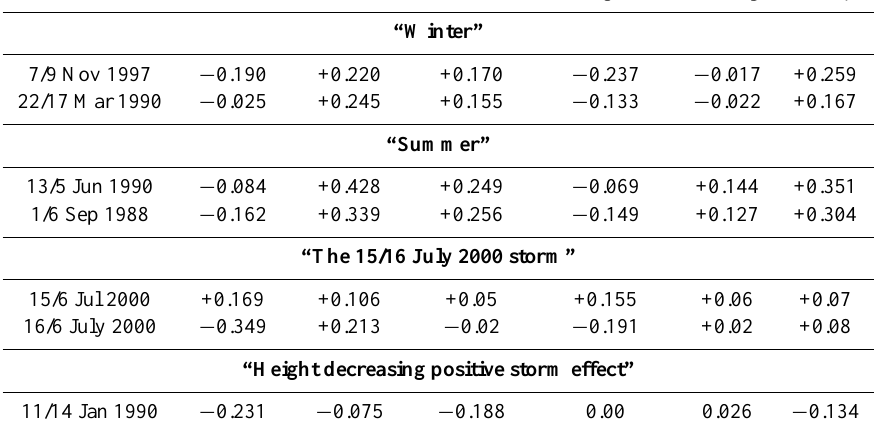
Table 6. Calculated variations at 180km in neutral composition, ion production rates and linear loss coefficient for “winter” and “summer” disturbances